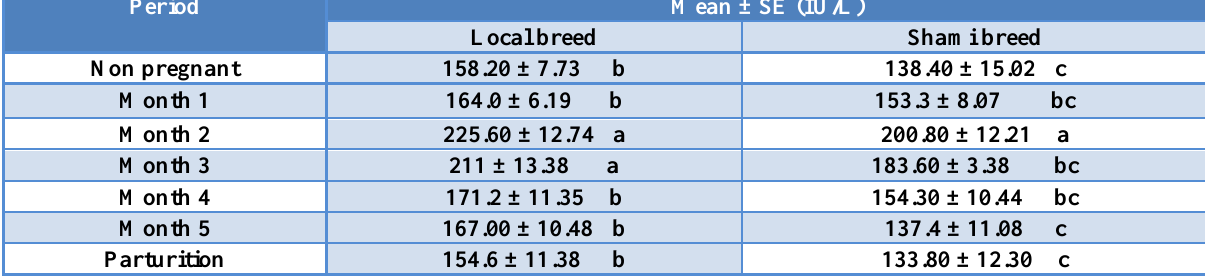
Table, 2: The mean value of (ALP IU/L) in non-pregnancy, pregnancy and parturition in Shami and Iraqi goats.